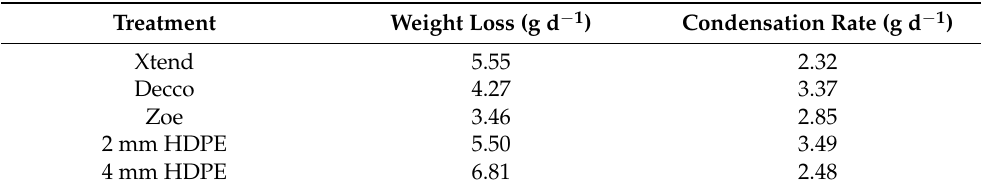
Table 1. Rate of moisture condensation and corresponding weight loss for 12 pomegranate fruit inside plastic liner bags, at 5 ◦ C and 90% relative humidity (RH). HDPE: high density polyethylene.